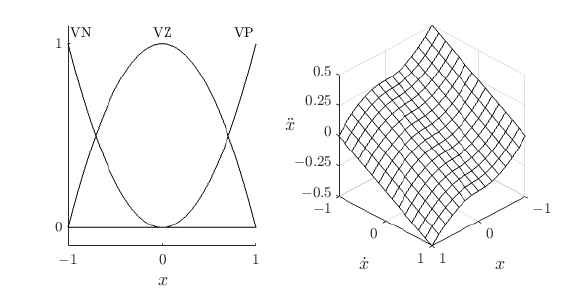
Figure 13. The concentration of the input membership functions x and the resulting inference map.